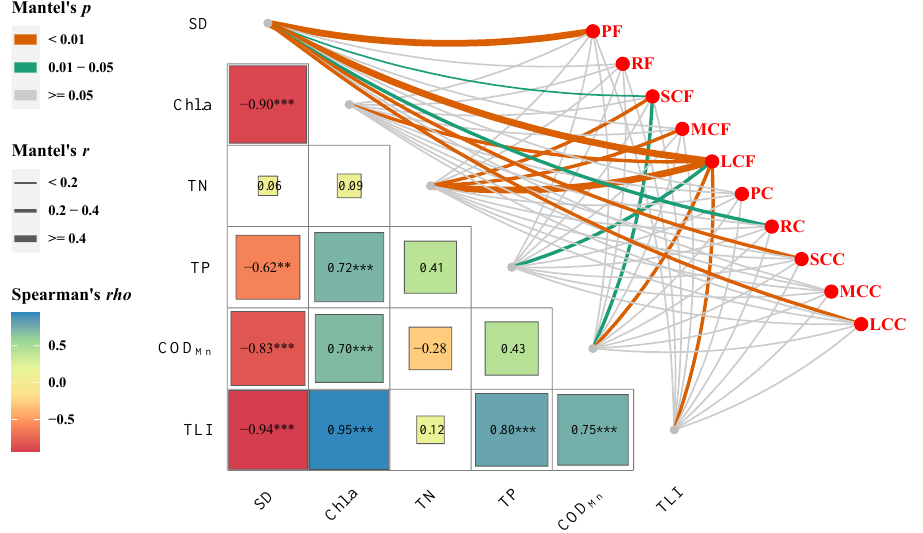
Figure 9. Correlations between functional groups and environmental parameters. The color gradient denotes Spearman’s correlation coefficients between each pair of the environmental factors. The label in each of the squares indicates the specific value of the correlation coefficient (***: p < 0.001, **: p < 0.01). The composition of all functional groups (based on the Euclidean distance of “hellinger” transformed biomass data) was related to each environmental factor (based on the Euclidean dis- tance) by Mantel’s test. Edge width corresponds to the Mantel’s r statistic for the correlation of the two corresponding distance matrices, and edge color indicates the statistical significance based on 999 permutations. SD: Secchi disk depth, Chl. a : chlorophyll a , TN: total nitrogen, TP: total phosphorus, COD Mn : permanganate index. 4. Discussion 4.1. Characteristics of the Zooplankton Composition and Biodiversity Despite the great importance of DJKR, limited field studies on zooplankton, espe- cially targeting the considered four taxonomic groups, have been published (Table S2). Our study indicated that the abundance and biomass of zooplankton increased remarka- bly after the reservoir was impounded, as predicted by experts before the construction of